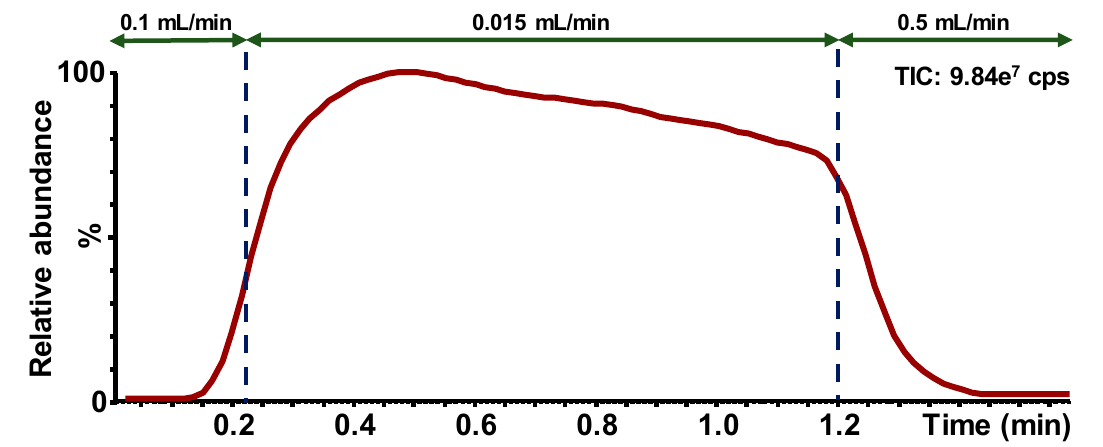
Figure 2. Example of ion chromatogram obtained for the screening test using the flow injection mode; Function 1 (ESI+); Flow rate modifications during the sample run are presented by the arrows; Cps = counts per second.